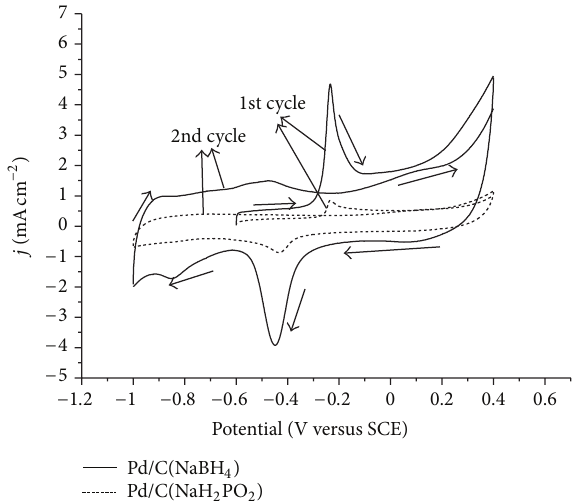
Figure 6: CO striping voltammetric curves of Pd/C (NaBH 4 ) and Pd/C (NaH 2 PO 2 ) in 1 mol ⋅ L −1 KOH